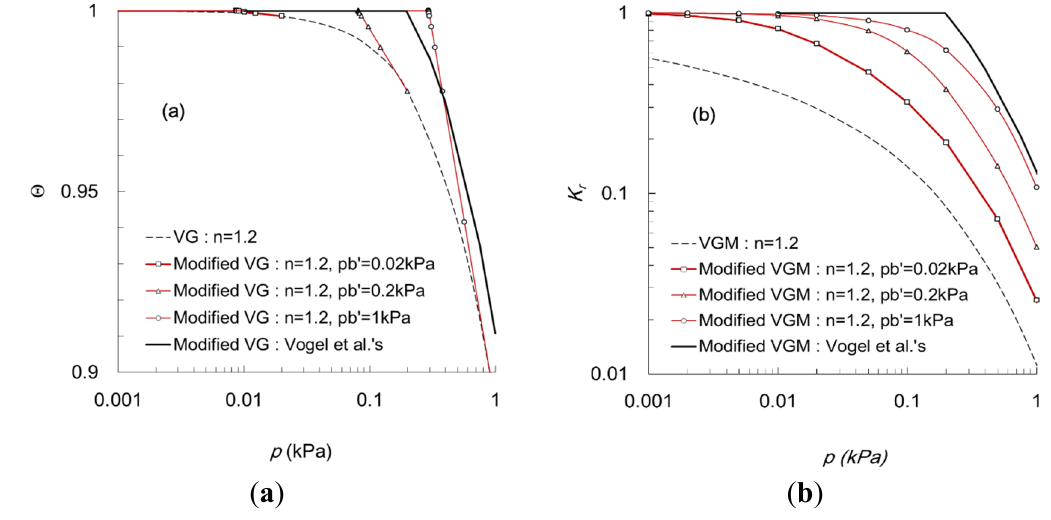
Figure 2. Effect of linearization by the modified SWRCs on K r functions ( p b = 1 kPa, n = 1.2, q = 0.5): ( a ) soil water retention curves; ( b ) hydraulic